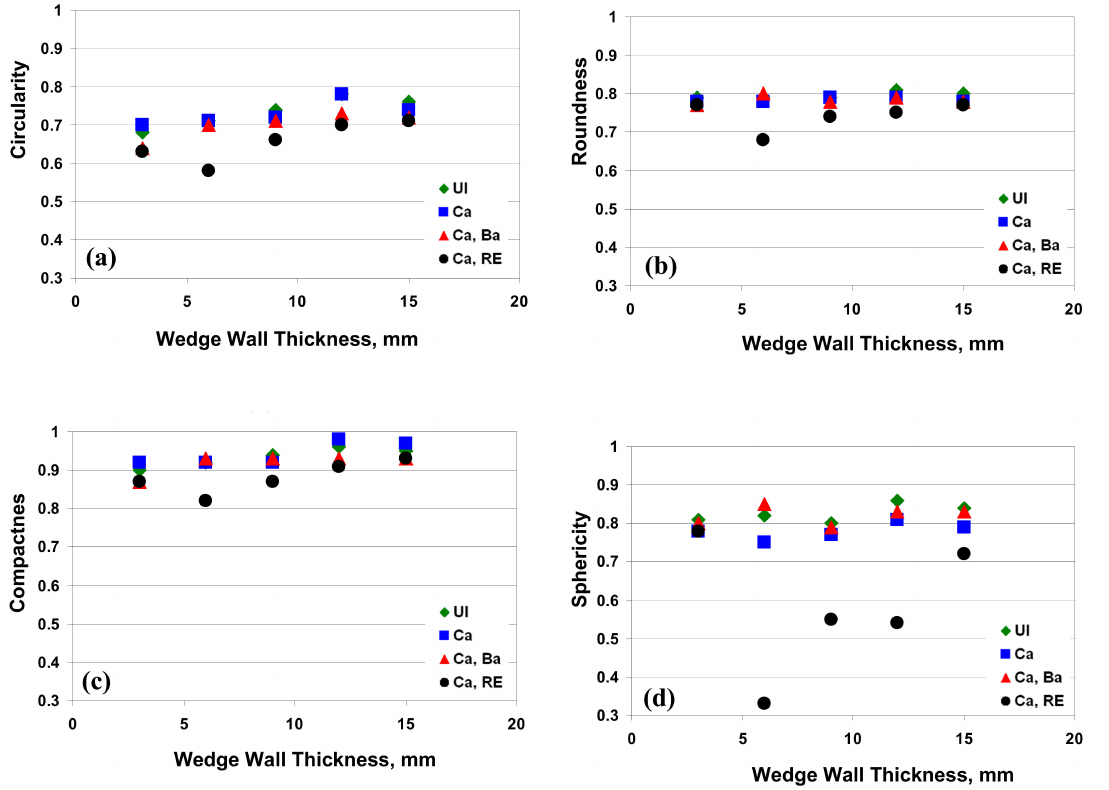
Figure 10. Gr aphite shape factors. ( a ) Circularity; ( b ) Roundness; ( c ) Compactness; ( d ) Sphericity.